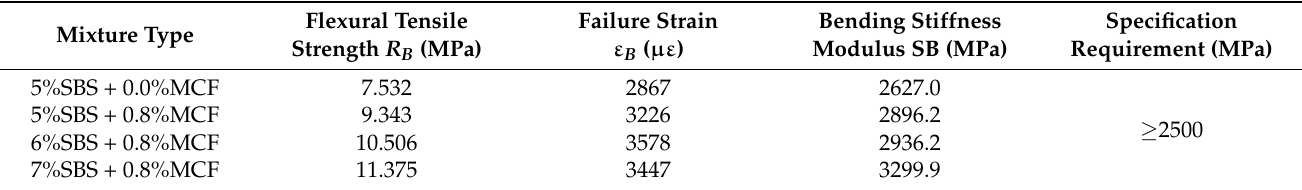
Table 8. Results of low-temperature bending tests.